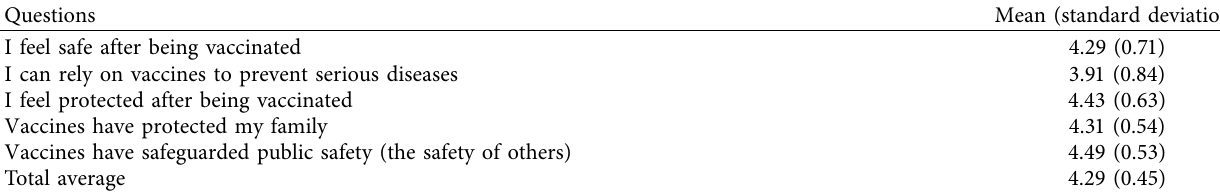
Table 3: COVID-19 vaccine efcacy awareness of the respondents.